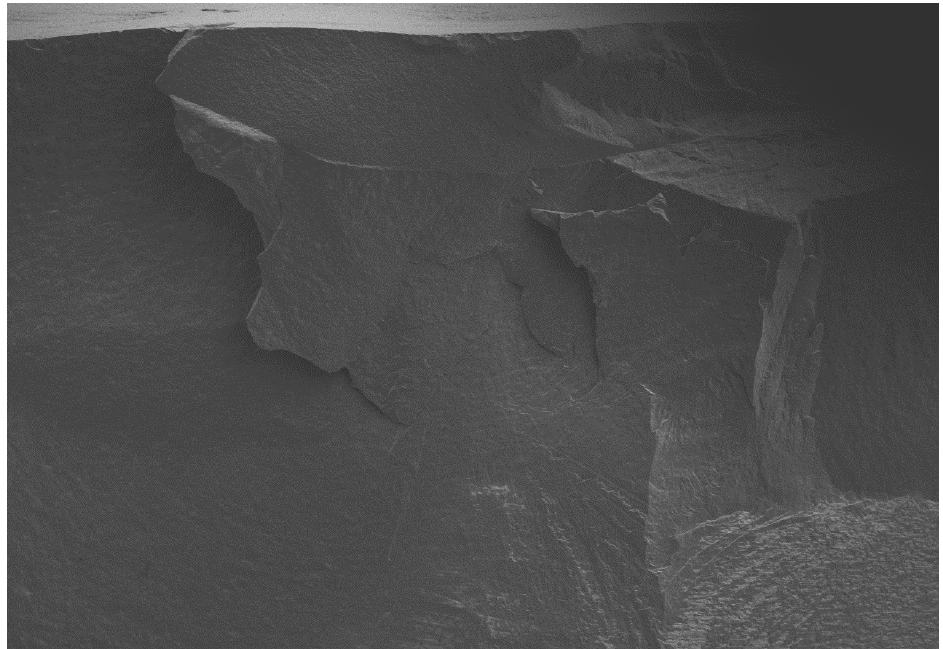
Figure 8. SEM micrograph of the fractured veneered-zirconia crown repaired with IPS e.max CAD at magnification of 22×.